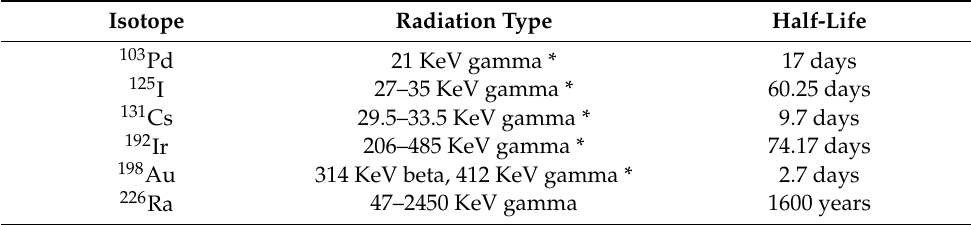
Table 2. Radioactive isotopes for